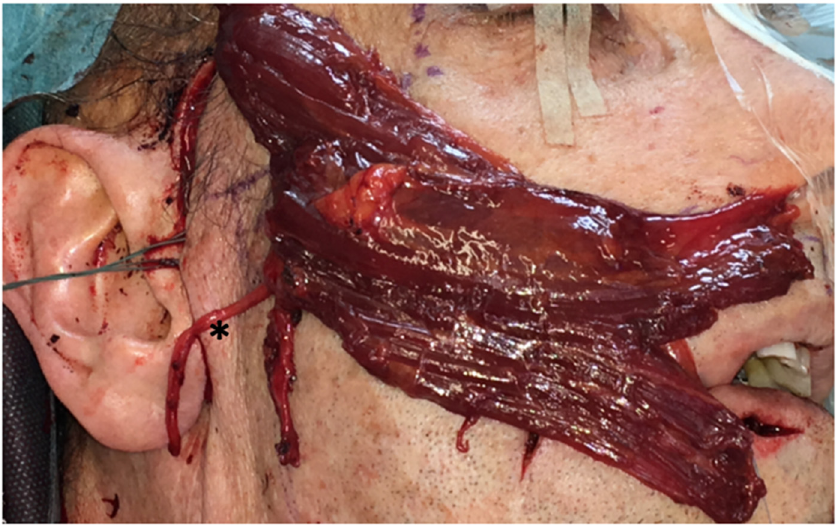
Figure 1. The gracilis muscle graft before implantation in the planned orientation on the right side. * marks the obturator nerve. * marks the obturator